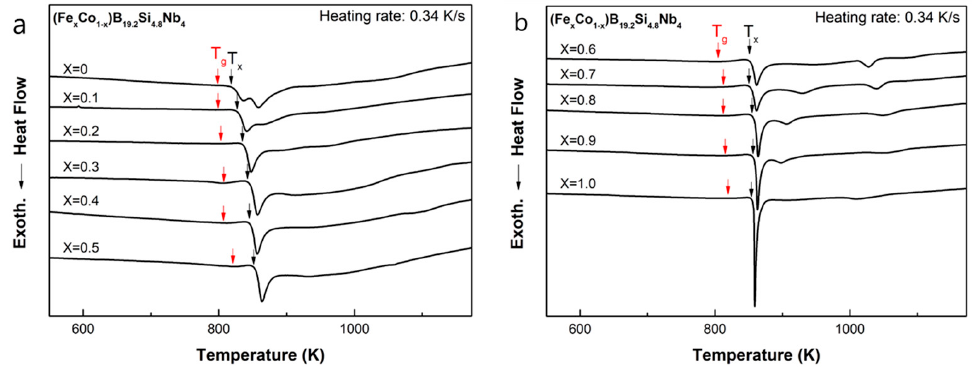
Figure 5. DSC curves of the (Fe x Co 1 − x ) 72 B 19.2 Si 4.8 Nb 4 as-spun ribbons ( a ) 0 ≤ x ≤ 0.5 ( b ) 0.6 ≤ x ≤ 1. Figure 6 shows the x-ray diffraction (XRD) patterns of the annealed (Fe x Co 1 − x ) 72 B 19.2 Si 4.8 Nb 4 (0.4 ≤ x ≤ 0.9, at 0.1 intervals) ribbons for 10 mins. After annealing